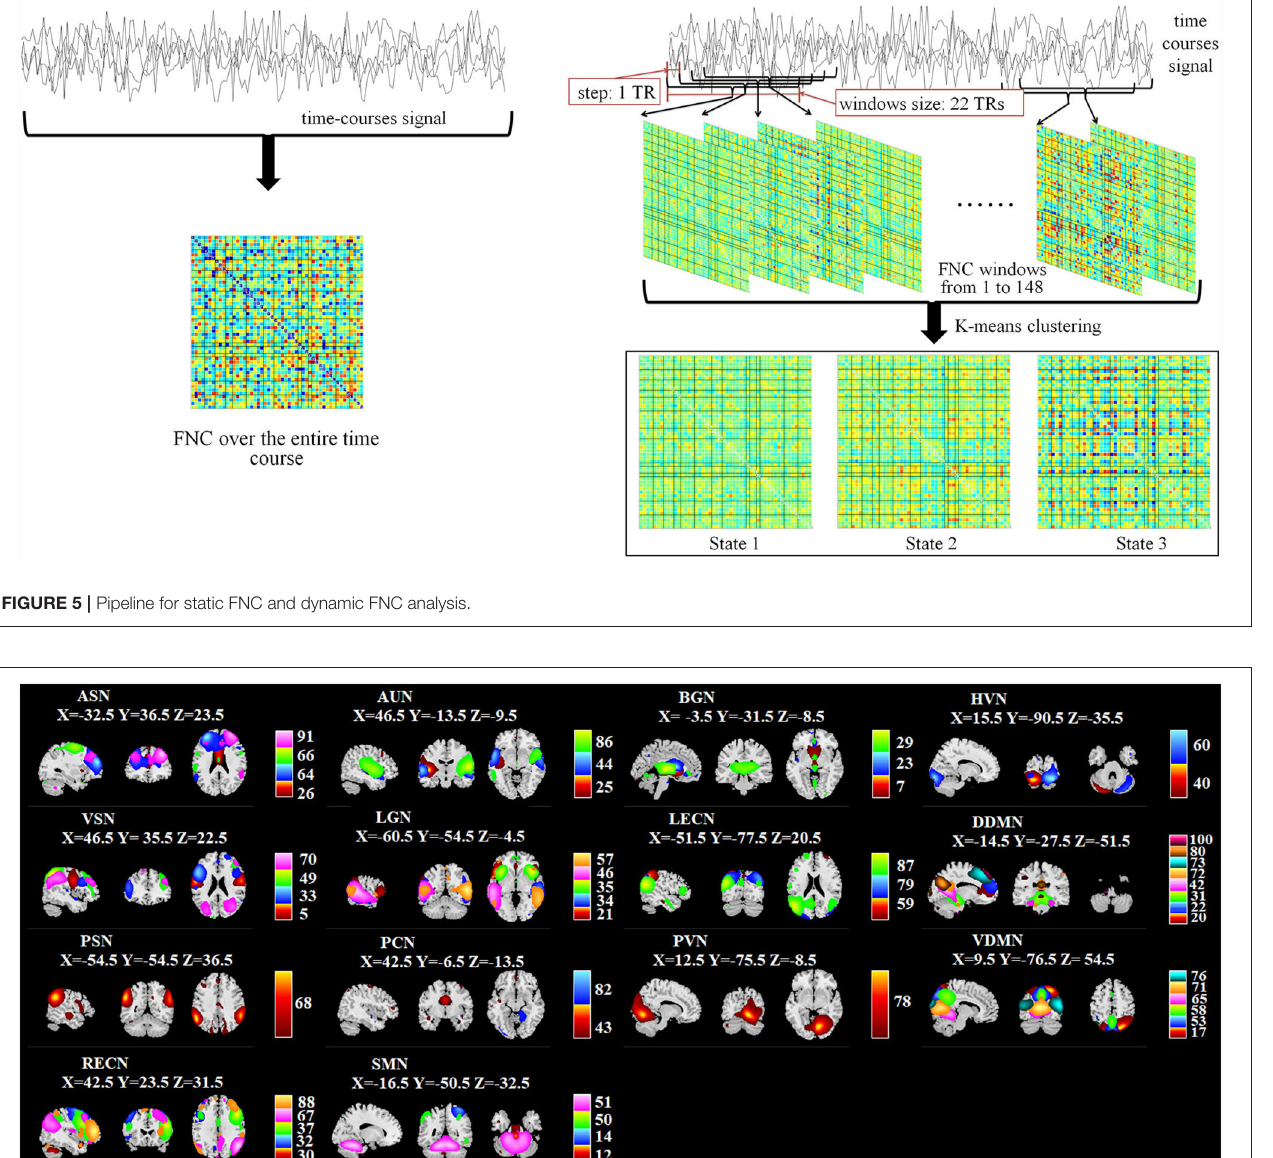
VDMN and RECN), enhanced connectivity between VDMN and LECN, PVN, SMN, PCN, PSN, also strong pairwise connectivity among ASN, BGN, AUN, and